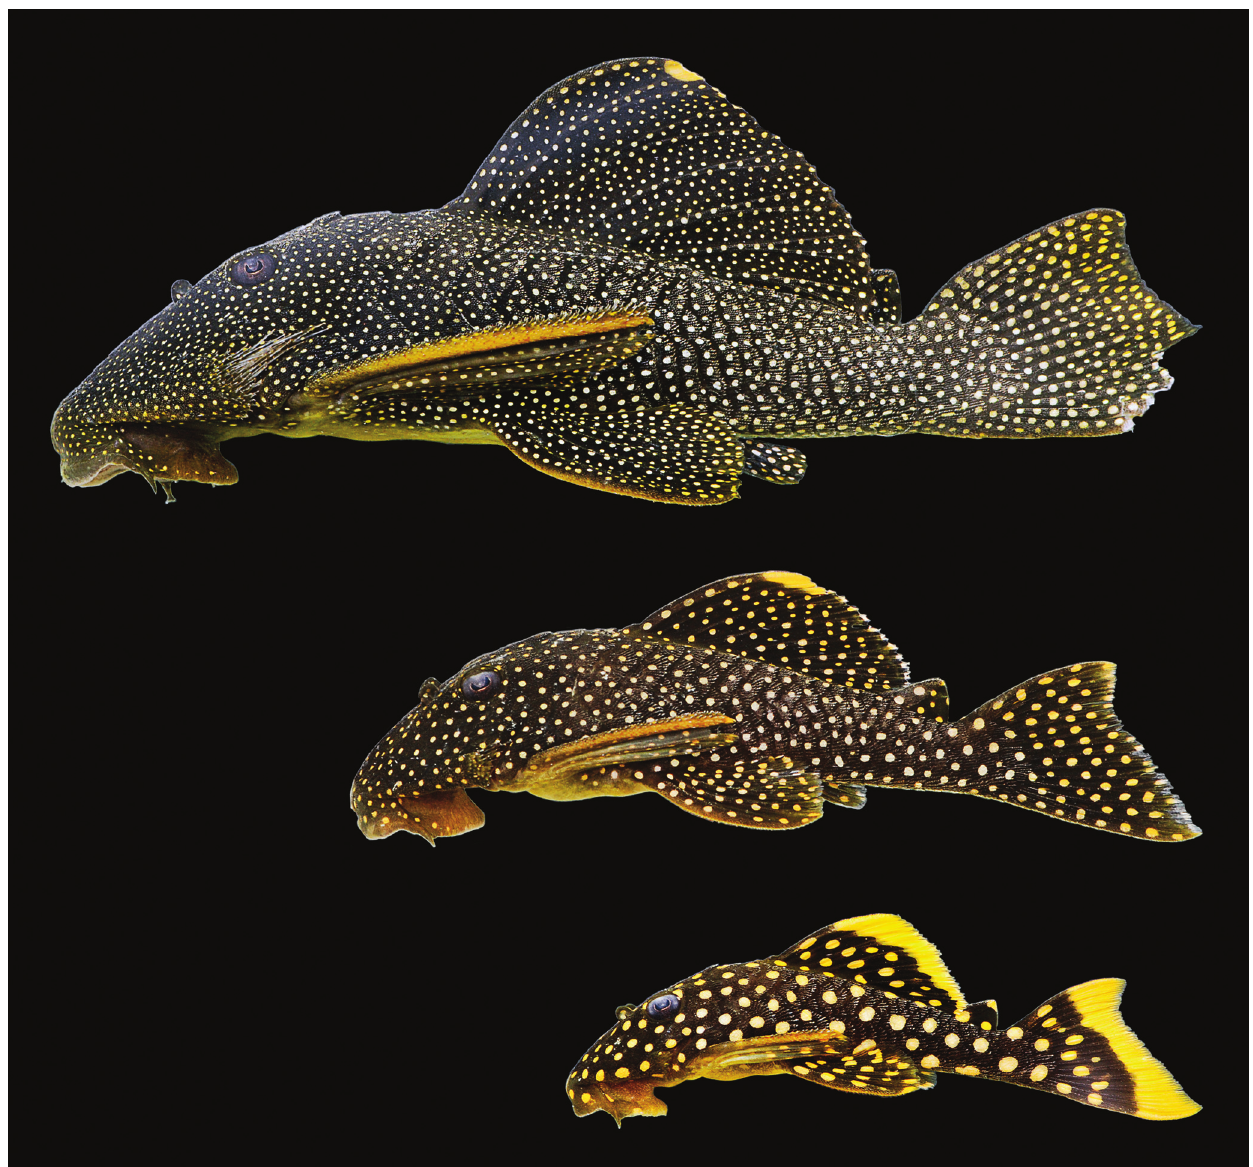
Fig. 2. Lateral view of live specimens of Baryancistrus xanthellus , INPA 31473, paratypes: (above) adult, 171.8 mm SL; (middle) subadult, 86.2 mm SL; (below) juvenile, 51.3 mm SL (photos RRO). Brazil, Pará, rio Xingu, Arroz